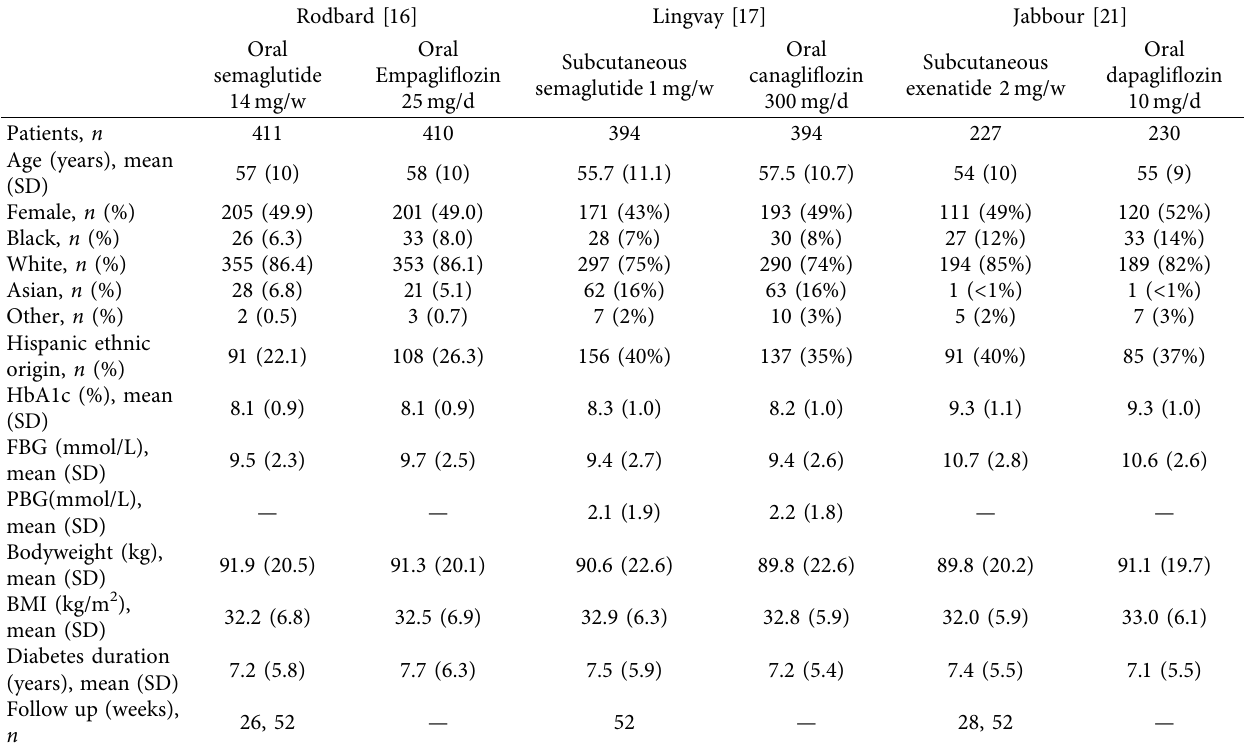
Table 1: Characteristics of the trials and baseline of the enrolled participants.